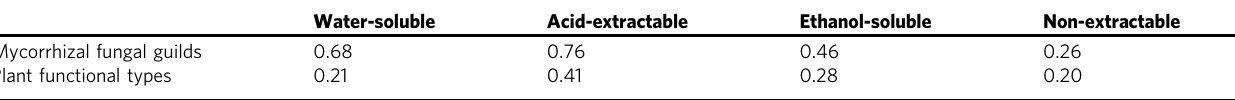
Table 1 Comparing effect sizes of WAEN conposition differences in plant litter and mycorrhizal